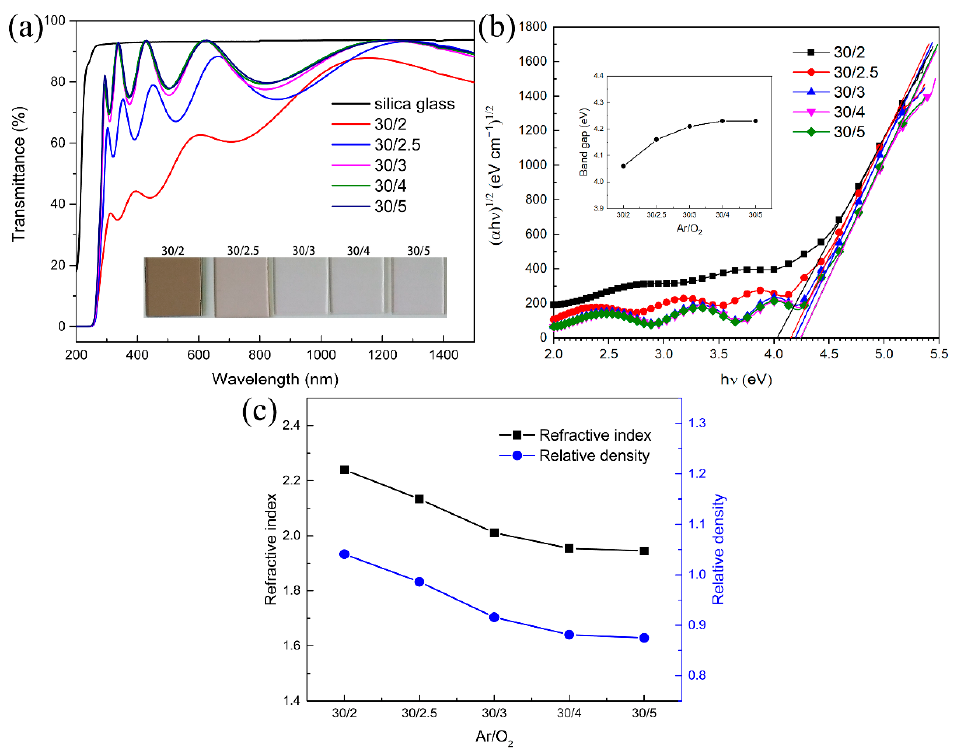
Figure 6. ( a ) Optical transmittance spectrum of the TaO x films sputtered with various Ar/O 2 ratio on silica glass, insert: the digital images of as-deposited films. ( b ) ( α h ν ) 1/2 vs. h ν plots of the TaO x films on silica glass, insert: the variation of band gap values for TaO x films. ( c ) The variation of refractive index and relative density of the TaO x films with different Ar/O 2 ratio.